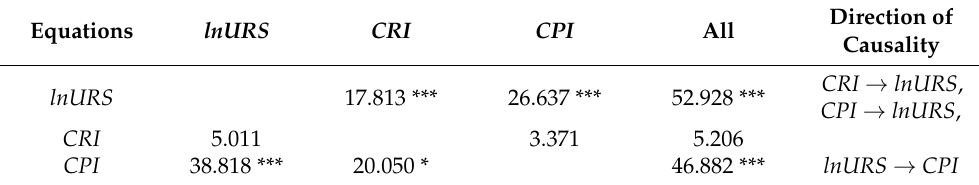
Table 8. Granger causality test results.